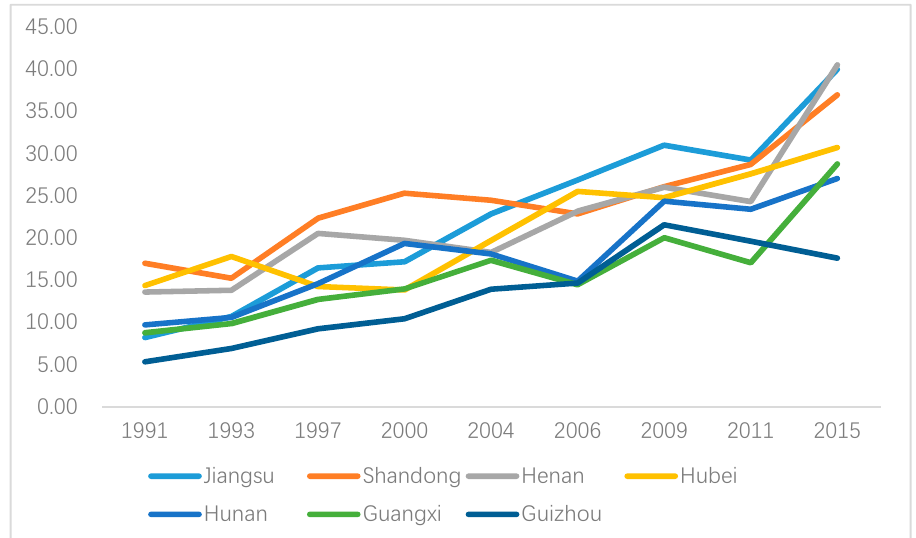
Figure 4. Area-specific hypertension prevalence (female).